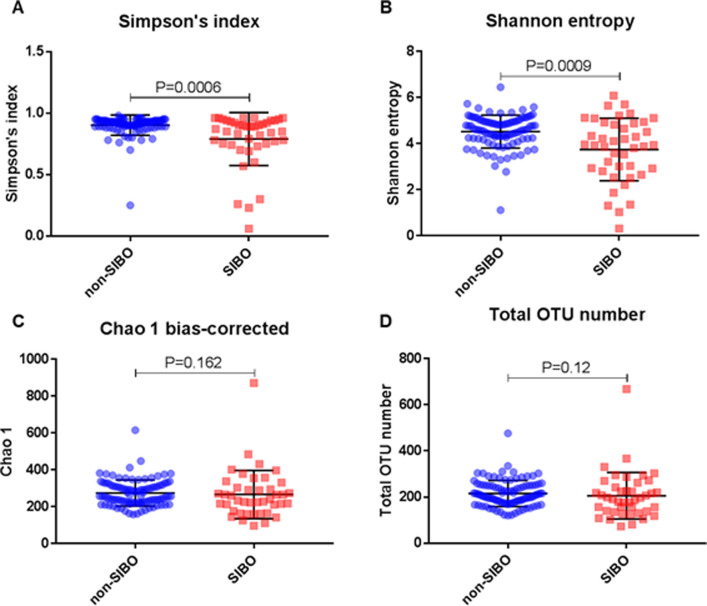
Alpha diversity of SIBO (N = 42) and non-SIBO (N = 198) subjects, as identified by microbial counts on MacConkey agar.A—Simpson’s index diversity; B—Shannon entropy diversity; C–Chao 1 diversity; D–Total number diversity.